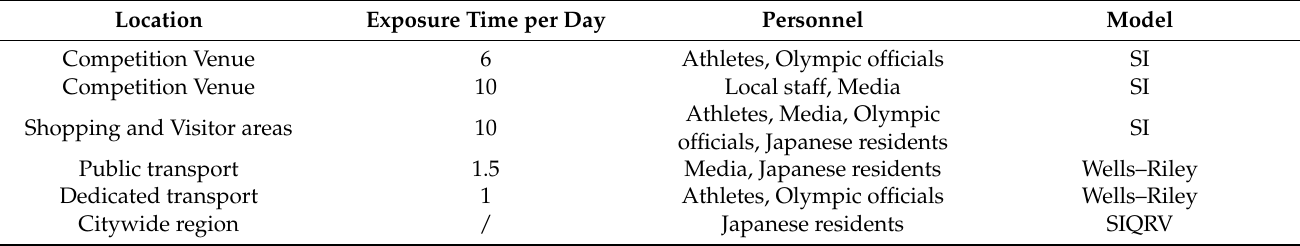
Table 2. The models used for different